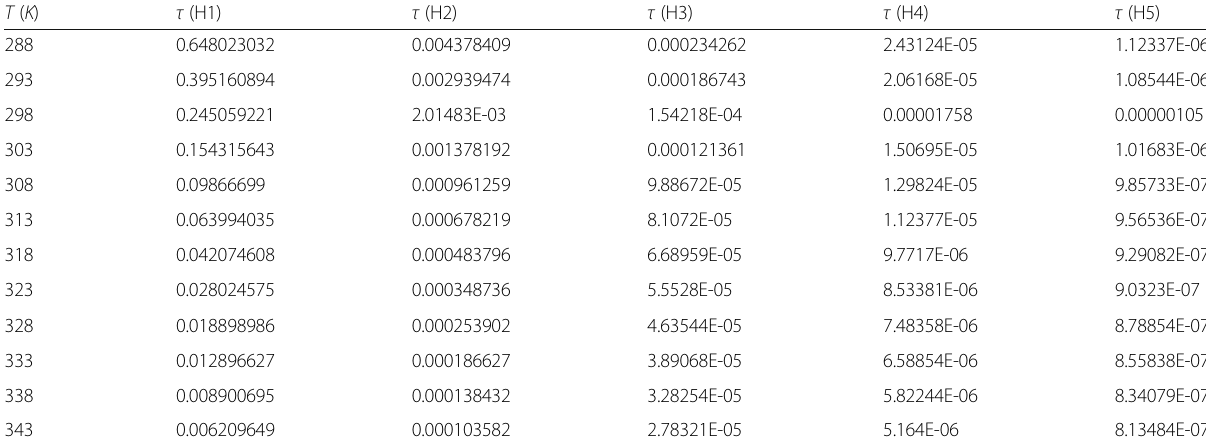
Table 2 Relaxation times of five energy levels corresponding to H1, H2, H3, H4, and H5; these times are used in fitting processes for AC-complex conductivity: electric conductivity and dielectric constant